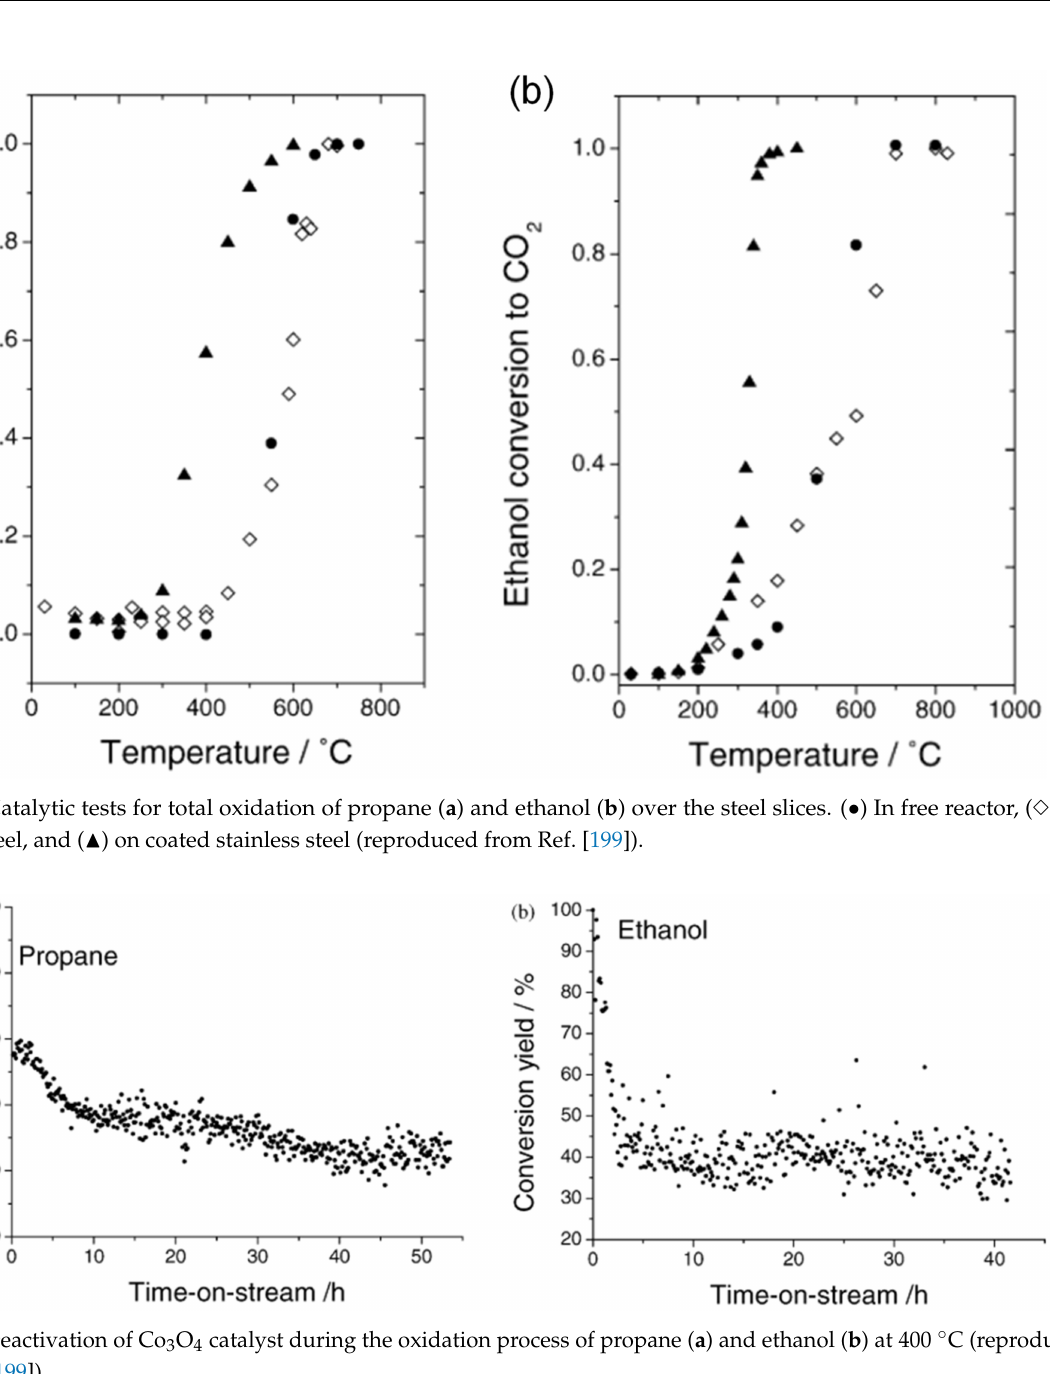
Figure 8. Deactivation of Co 3 O 4 catalyst during the oxidation process of propane ( a ) and ethanol ( b ) at 400 ◦ C (reproduced from Ref.